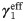
Effect of the feedback strength on noisy images from natural images database.(A) In the left column, one image is corrupted by Gaussian noise of mean 0 and a standard deviation of 2 (σ). The central column exhibits the representations made by the first layer (γ1eff), and the right-hand column the representations made by the second layer (γ2eff). Within each of these blocks, the feedback strength (kFB) is equal to 0 in the top line and 4 in the bottom line. (B) We plot the structural similarity index (higher is better) between original images and their representation by the first layer of the SDPC. (C) We plot the structural similarity index between original images and their representation by the second layer of the SDPC. All curves represent the median structural similarity index over 1200 samples of the testing set and present a logarithmic scale on the y-axis. The color code corresponds to the feedback strength, from grey for kFB = 0 to darker blue for higher feedback strength. The black line is the baseline, it is the structural similarity index between the noisy and original input images.